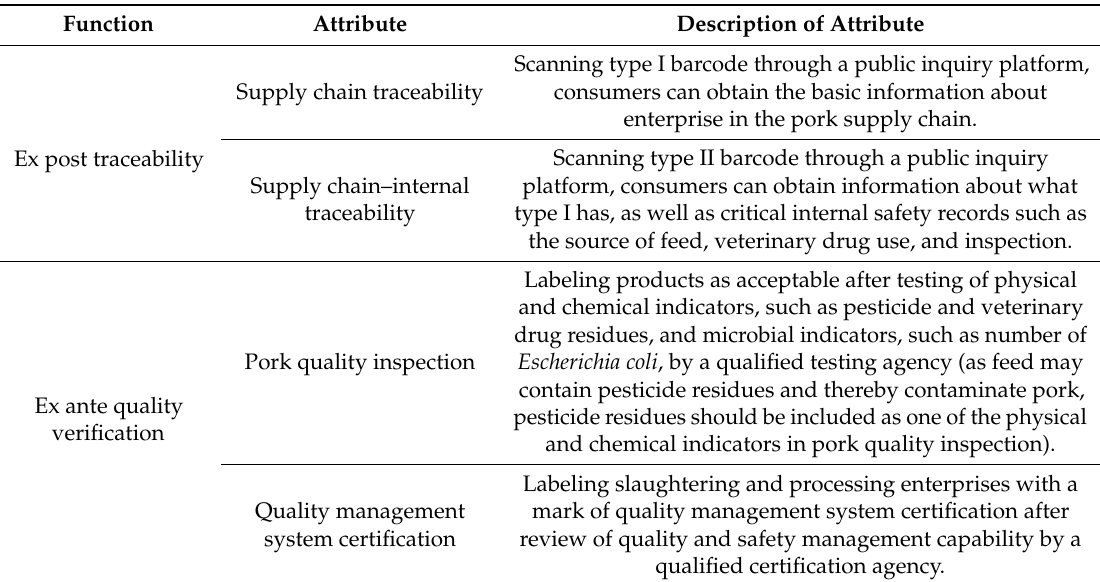
Table 1. Attributes and price levels of traceable pork with di ff erent functions (price: yuan / 500 g). Function Attribute Description of Attribute Scanning type I barcode through a public inquiry platform, Supply chain traceability consumers can obtain the basic information about enterprise in the pork supply Ex post traceability